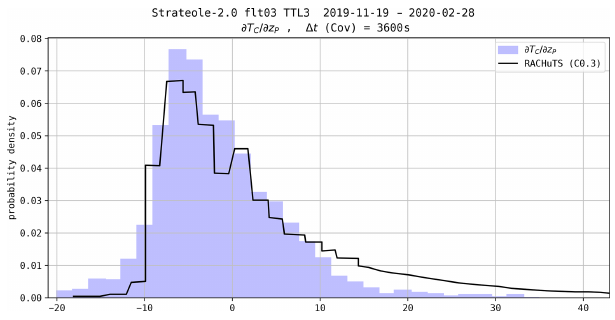
Figure 12. Histograms of ∂T/∂z P from the covariance of the TSEN measurements (blue shading) and from the RACHuTS temperature profile (black line). The two histograms have common characteris- tics, despite the fact that they are not obtained at the same altitude